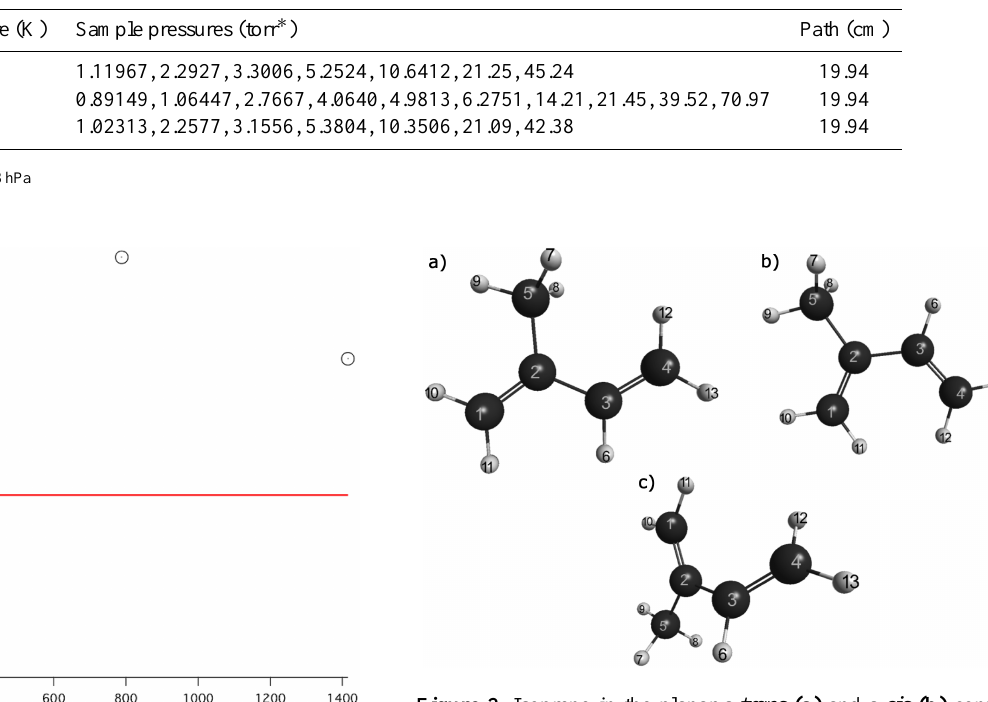
Figure 2. Isoprene in the planar s- trans (a) and s- cis (b) confor- mations. The gauche s- cis conformation is shown in (c) , with the dihedral angle, C1-C2-C3-C4 = 35 ◦ , corresponding to the structure calculated by Squillacote and Liang (2005) using the G3B3 method. Molecular structures were generated using the MacMolPlt graphical user interface (Bode and Gordon,